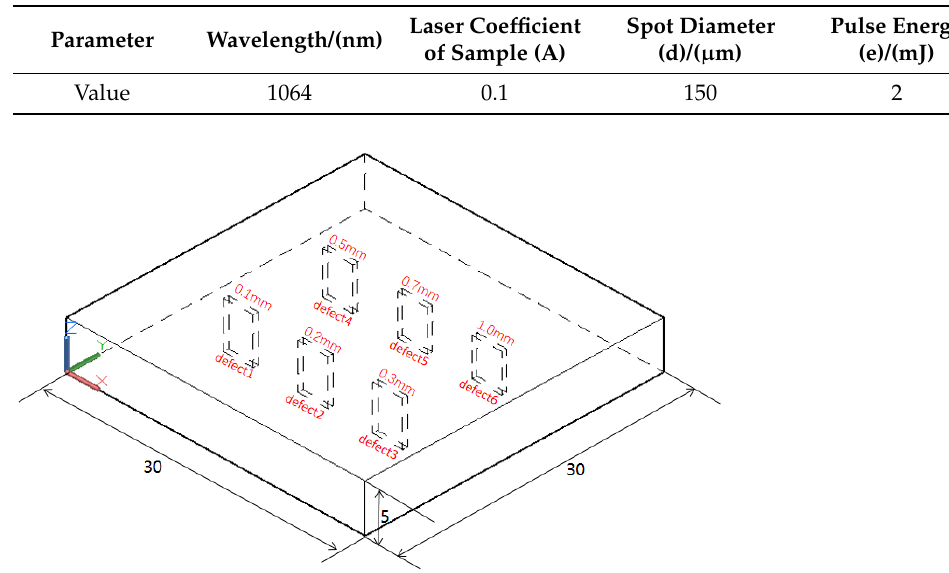
Figure 1. LGU testing system. Table 1. WEDGE 1064 HB DB parameters.